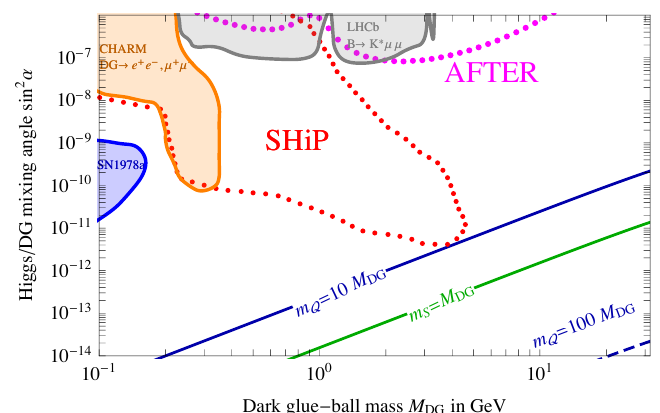
Figure 9 . Predicted values of the Higgs/dark gluon mixing angle (cid:11) , assuming dark quarks with Yukawa couplings y = 1 (blue lines) or adding a dark scalar with mass m S (green line) with a mixed quartic (cid:21) HS = 10 (cid:0) 2 , as function of the dark gluon mass M . The shaded regions are excluded, the DG dotted curves can be probed by future SHiP [65] (red points) and AFTER [66] (magenta points) experimental